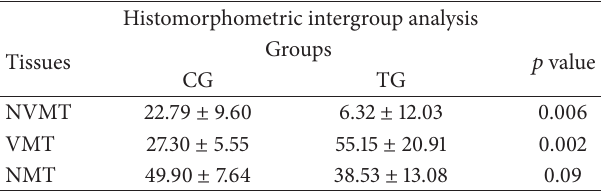
Table 1: Statistical comparison of mean values (in percentage, %) between CG and TG. Histomorphometric intergroup